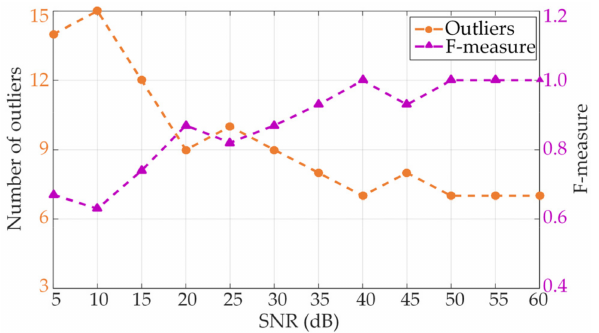
Figure 7. The relationship between SNR, F-measure, and the number of detection outliers.